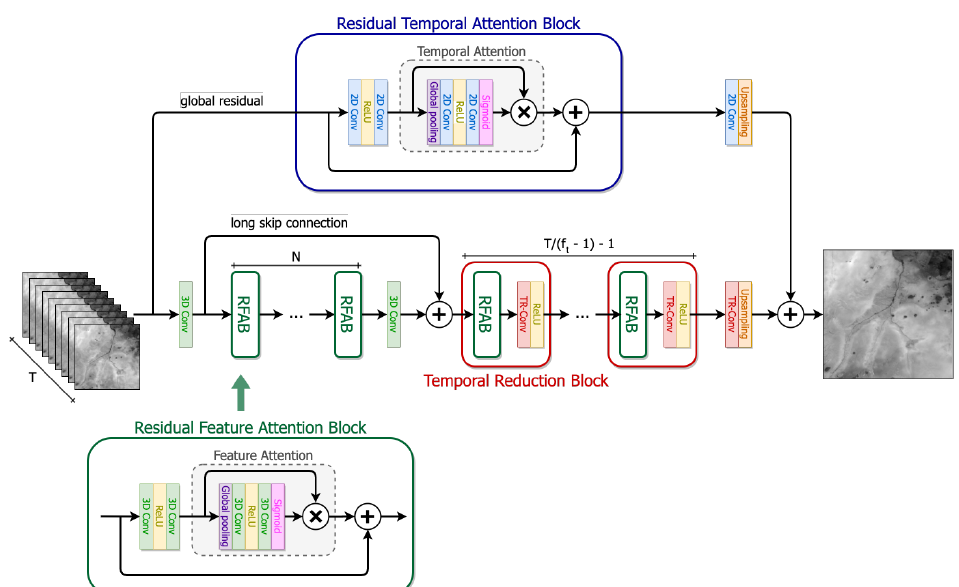
Figure 1. Overview of the Residual Attention Multi-image Super-resolution Network (RAMS), assuming to work with single-channel LR images ( C = 1) to simplify the discussion. A tensor of T single-channel LR images constitutes the input of the proposed model. The main branch extracts features, with 3D convolutions, in a hierarchical fashion, while a feature attention mechanism allows the network to select and focus on most promising inner representations. Concurrently, a global residual path exploits a similar attention operation in order to make an aware fusion of the T distinct LR images. All computations are efficiently performed in the LR feature space and only at the last stage of the model an upsampling operation is performed in both